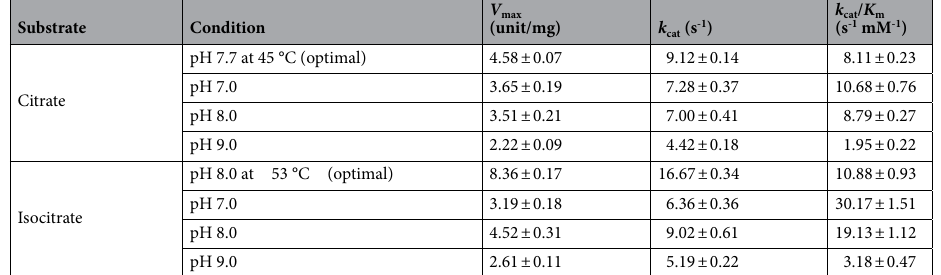
Table 2. Kinetic parameters of Sy AcnB. The optimal conditions were measured for trisodium citrate dihydrate in Tris–HCl buffer pH 7.7 at 45 °C and for dl-isocitrate trisodium salt hydrate in Tris–HCl buffer pH 8.0 at 53 °C. The other six parameters were measured in Tris–HCl buffer pH 7.0, 8.0, and 9.0 at 30 °C. Mean ± standard deviation values were calculated from three independent experiments. The P -values between citrate and isocitrate calculated by Student’s t -test were listed in Table S3.